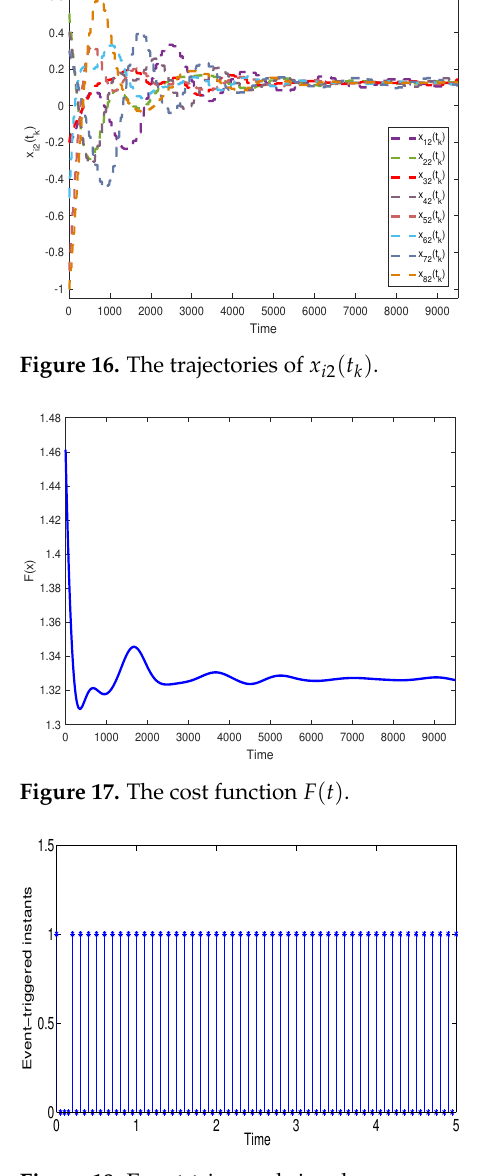
Figure 18. Event-triggered